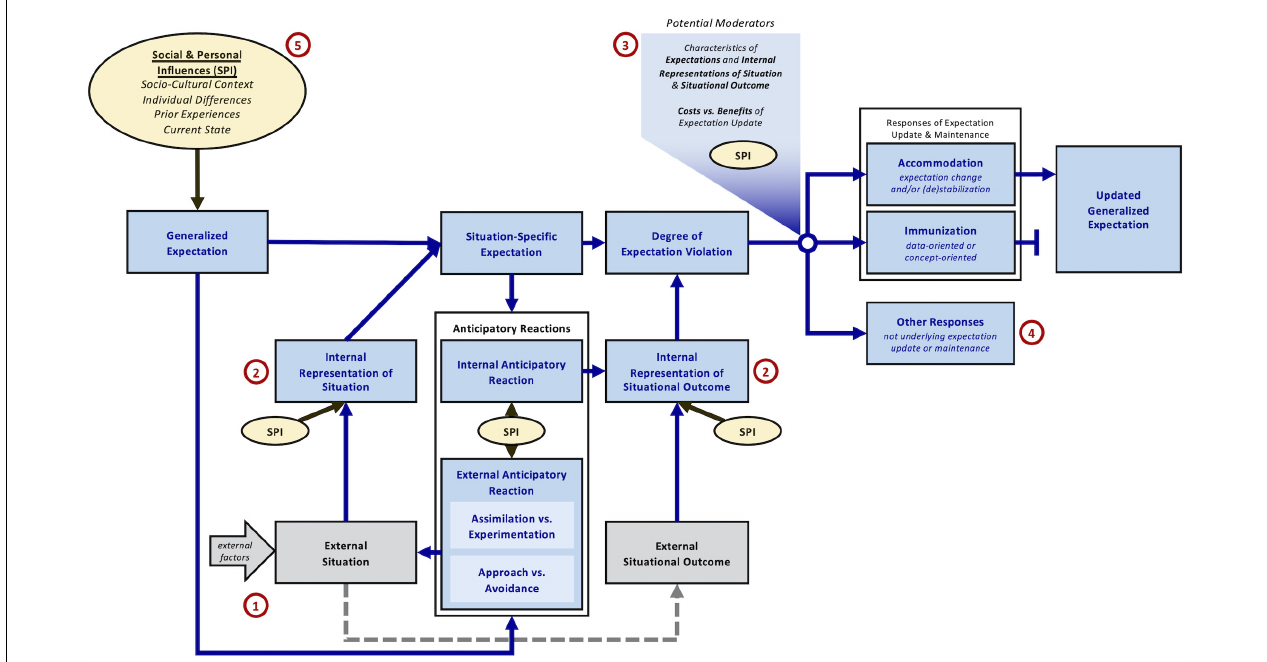
FIGURE 3 | Functional level (Level 2) of the ViolEx 2.0 model. Specifications in addition to Level 1: (1) The external situation is influenced by the external anticipatory reaction and external factors outside the individual. It influences the situation-specific expectation (via the internal representation of the situation) and it ultimately leads to the external situational outcome (dashed line); (2) Distinction between the objective external situation/situational outcome (gray boxes) and their internal representations; (3) Influences on the selection of accommodation versus immunization include characteristics of the expectations, internally represented characteristics of the situation and situational outcome, potential costs versus benefits of expectation update, as well as social and personal influences [see (5)]; (4) Other responses to expectation violations that are not underlying expectation update versus maintenance; and (5) Pathways of social and personal influences (SPI) are specified: the socio-cultural context, individual differences, prior experiences, and the individual’s current state can influence generalized expectations, internal representations of situation and situational outcome, anticipatory reactions, and selection of accommodation versus